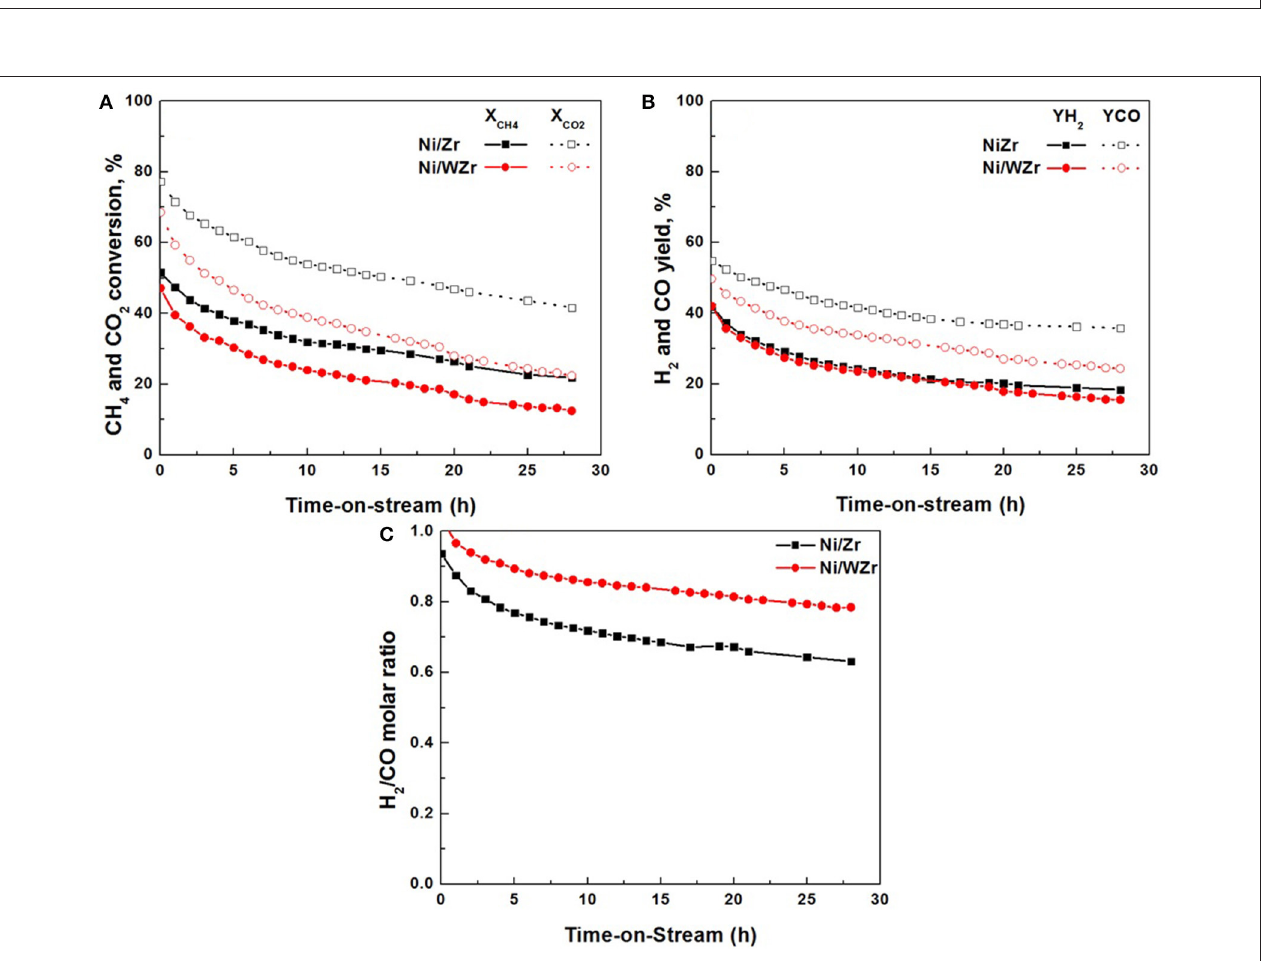
FIGURE 8 | Time-on-stream catalytic performance and stability of Ni/Zr and Ni/WZr catalysts at 750 ◦ C: (A) CH 4 and CO 2 conversions, (B) H 2 and CO yields, %, (C) H 2 /CO molar ratio; Reaction conditions: Total feed flow rate of 100mL min − 1 (30%CH 4 /20%CO 2 /50%He).